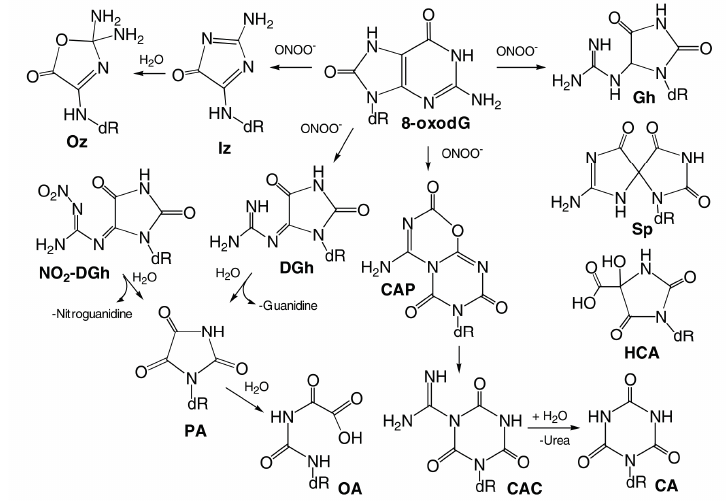
Figure 5. Products of peroxynitrite oxidation of 8-oxodG. Adapted from [94] with the permission of Elsevier, Inc.,